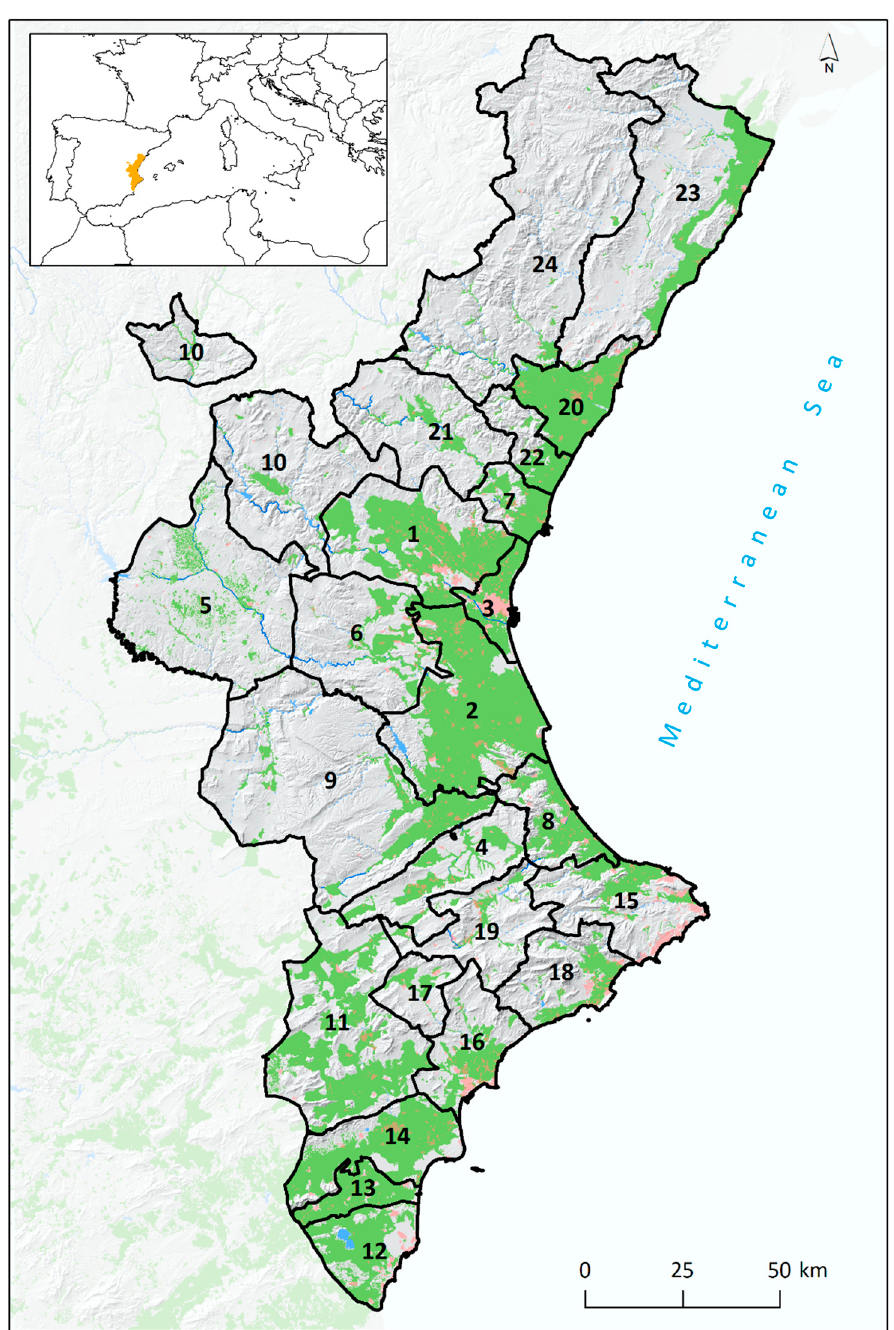
Figure 1. Workshops took place in these 24 clusters, defined according to agronomic, water resource and geographical criteria. Green coloured areas represent the irrigable areas in the region. 1. Camp de Túria, 2. Ribera del Xúquer, 3. L’Horta de València, 4. Vall d’Albaida, 5. Requena-Utiel, 6. Buñol-Chiva, 7. Camp de Morvedre, 8. La Safor, 9. Caroig-C à nyoles, 10. Alto Turia, 11. Vinalop ó , 12. La Pedrera, 13. Vega Baja, 14. Riegos de Levante, 15. Marina Alta, 16. Alacant í , 17. Foia de Castalla, 18. Matina Baixa, 19. Alcoi à -Comtat, 20. Plana de Castell ó , 21. Alto Palancia, 22. Plana Baixa,